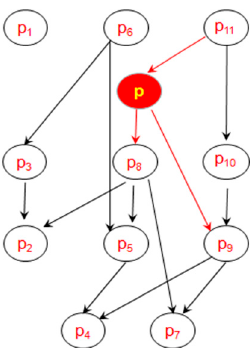
Figure 6. Updating DSG when a new point arrives.